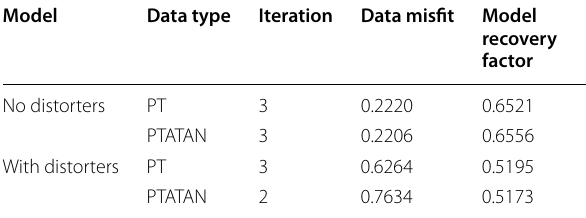
Table 4 Summary of the inversion metrics of PT and